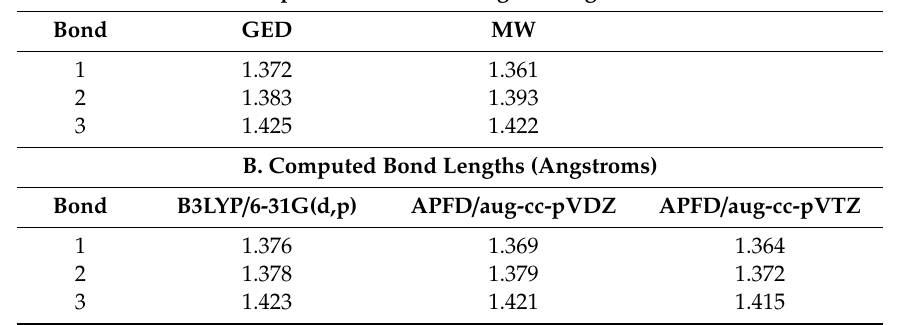
Table 8. Experimental gas phase electron diffraction (GED) and microwave (MW) structures corresponding to the designated bonds in N-methylpyrrole (Part A) in comparison with computed structures (Part B).